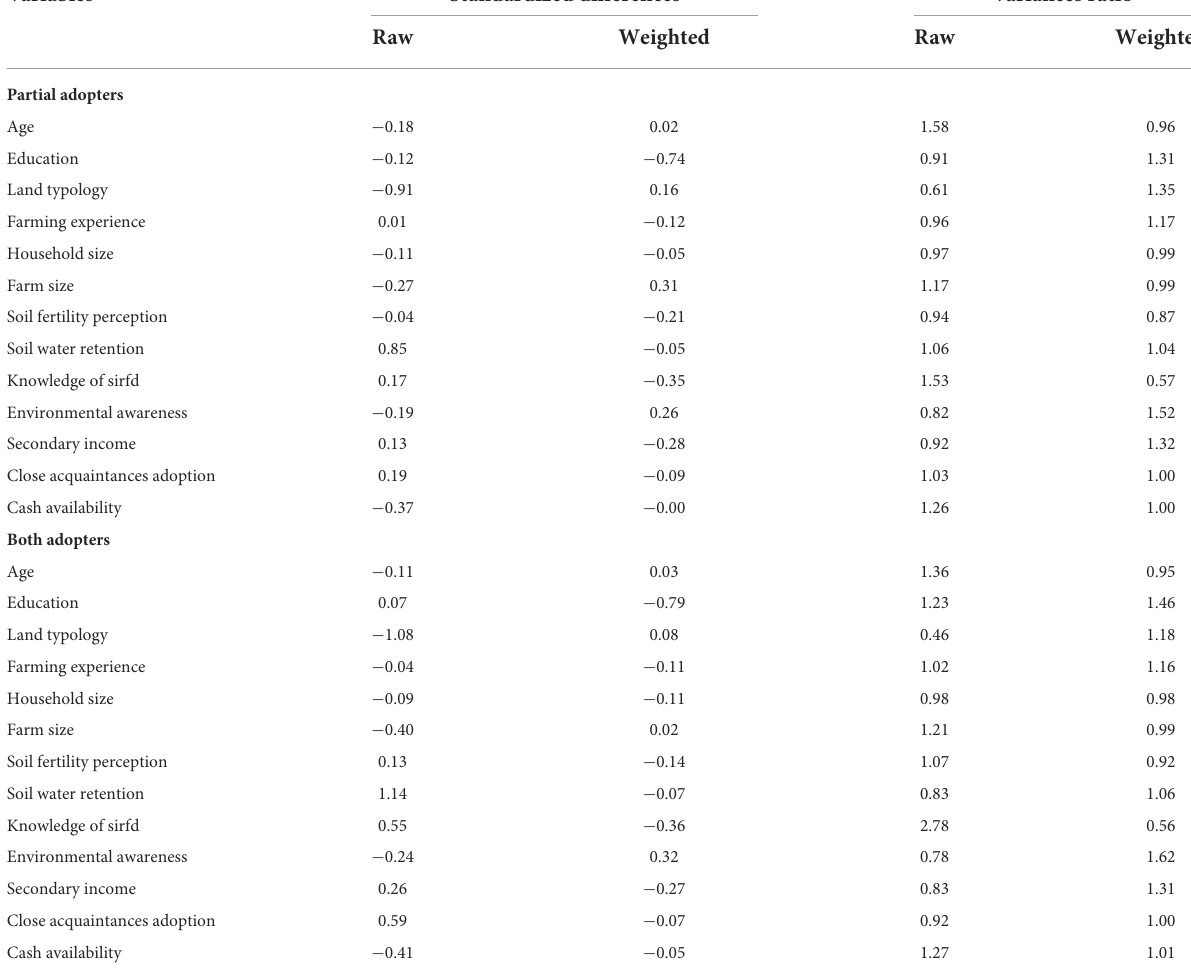
TABLE 4 Covariates balancing